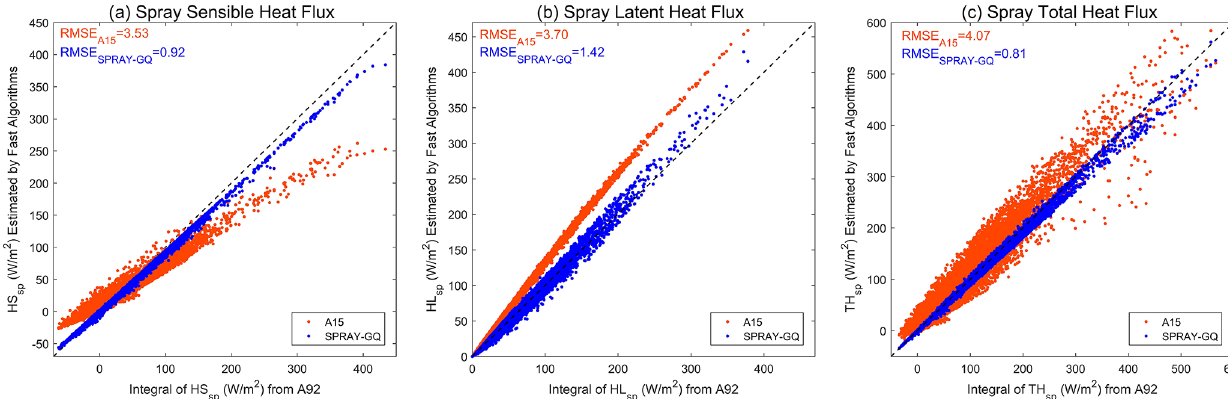
Figure 5. The same as Fig. 4, but SWH is derived by WSP10 instead of ERA5